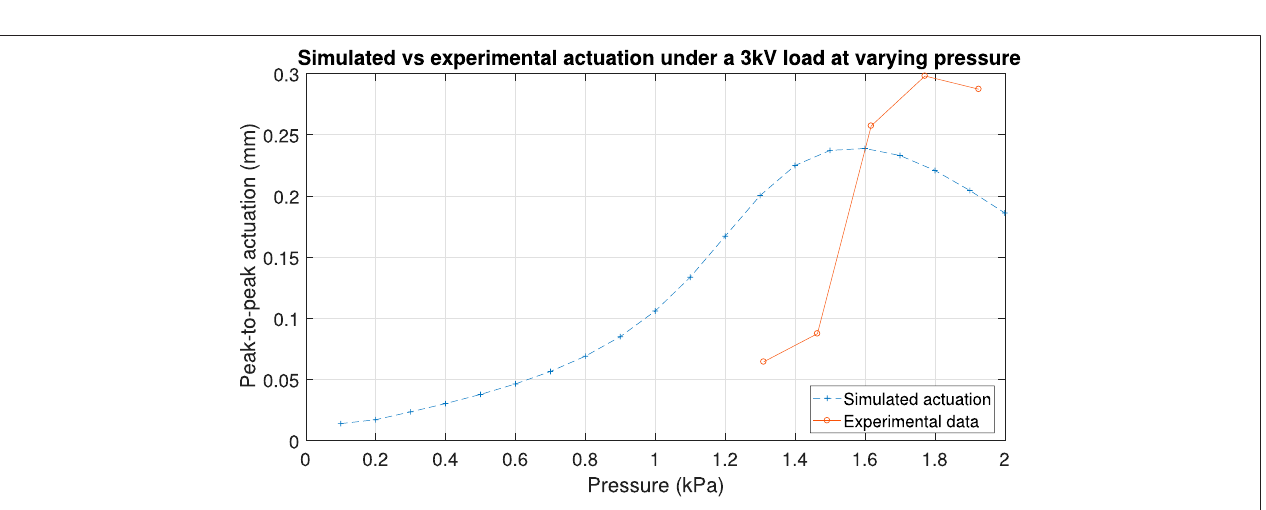
FIGURE 12 | FEM Comparison 2. Simulated horizontal actuation (simultaneous actuation of two adjacent MIDA segments) under a 3 kV peak to peak sinusoidal load with 1.5 kV DC offset at varying pressure (blue) vs experimental actuation under the same conditions (orange) measure using the laser displacement sensor.